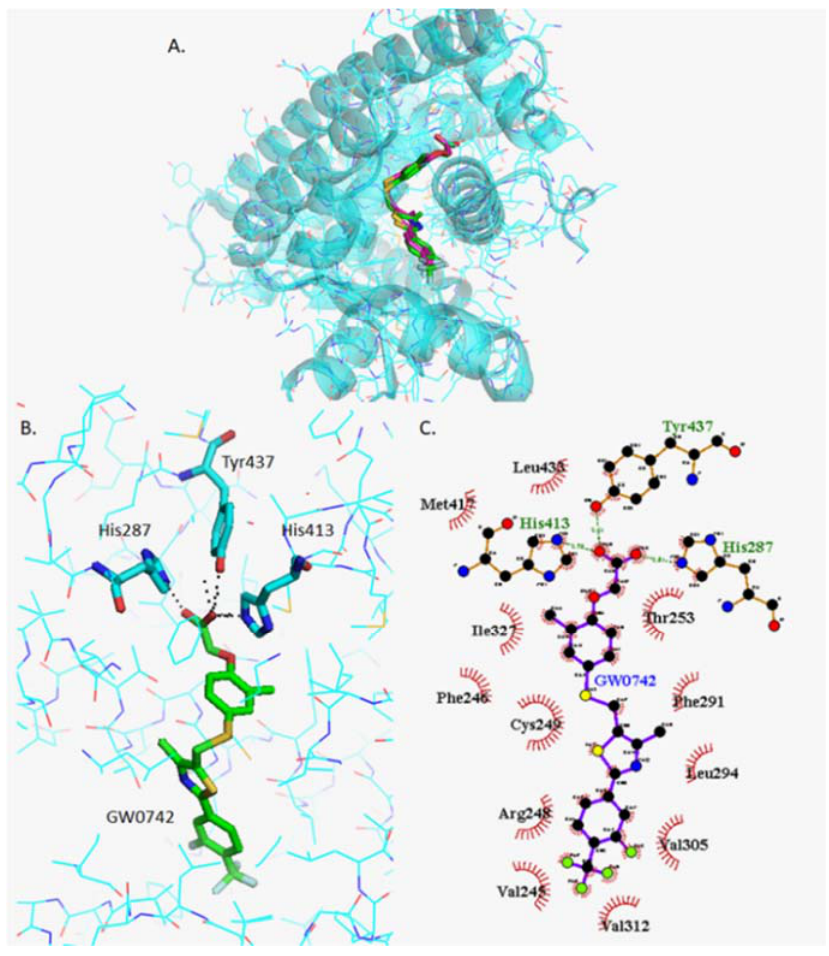
Figure 3. Analysis of GW0742 docked into PPAR β / δ (PBD:3TKM). ( A ) Representation of the most stable GW0742 docking conformation (green) compared to the GW0742 of the crystal structure (pink). ( B ) 3D detail of the amino acids forming polar bindings with GW0742 calculated by Pymol. Colour coding of atoms: red O, blue N, mustard S, white F, pink C of GW0742 from the crystal structure, green C of GW0742 docked into the crystal structure, cyan C from PPAR β / δ . ( C ) Schematic 2D representation of the interaction between PPAR β / δ LBD and GW0742 calculated using Ligplot+. The green dashed lines indicate polar interactions and the red spoked arcs indicate hydrophobic interactions. Colour coding of atoms: red O, blue N, yellow S, green F, black C.